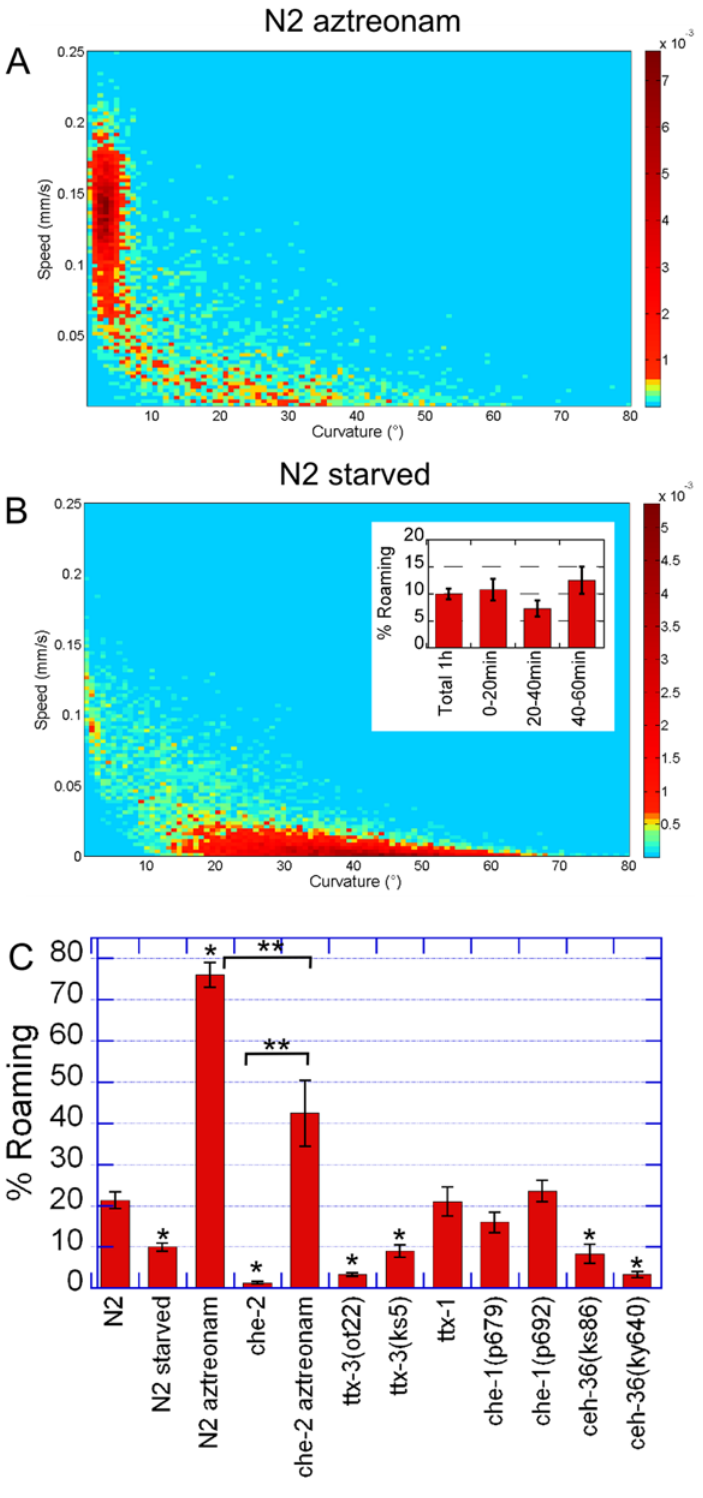
Figure 3. Influence of food perception and experience. (A–B) Data density maps for (A) N2 worms feeding on aztreonam treated bacteria. Compared to N2 worms in standard conditions (Fig 1-D) the dwelling cluster is suppressed (B) N2 worms feeding on standard OP50 bacteria after a 1 h fasting period. The roaming cluster is suppressed. Insert: Proportion of time spent roaming during the 0–20 min, 20–40 min and 40–60 min time intervals after a one-hour starvation period. (C) Quantitative measurements of the percentage of time spent roaming of N2 worms in aztreonam (A) and fasting (B) conditions and of mutants that have sensory perception defects. At least 20 worms were recorded per condition. Results are presented as mean 6 s.e.m. *Different from wild type, p , 0.01 **Different from each other p , 0.01.